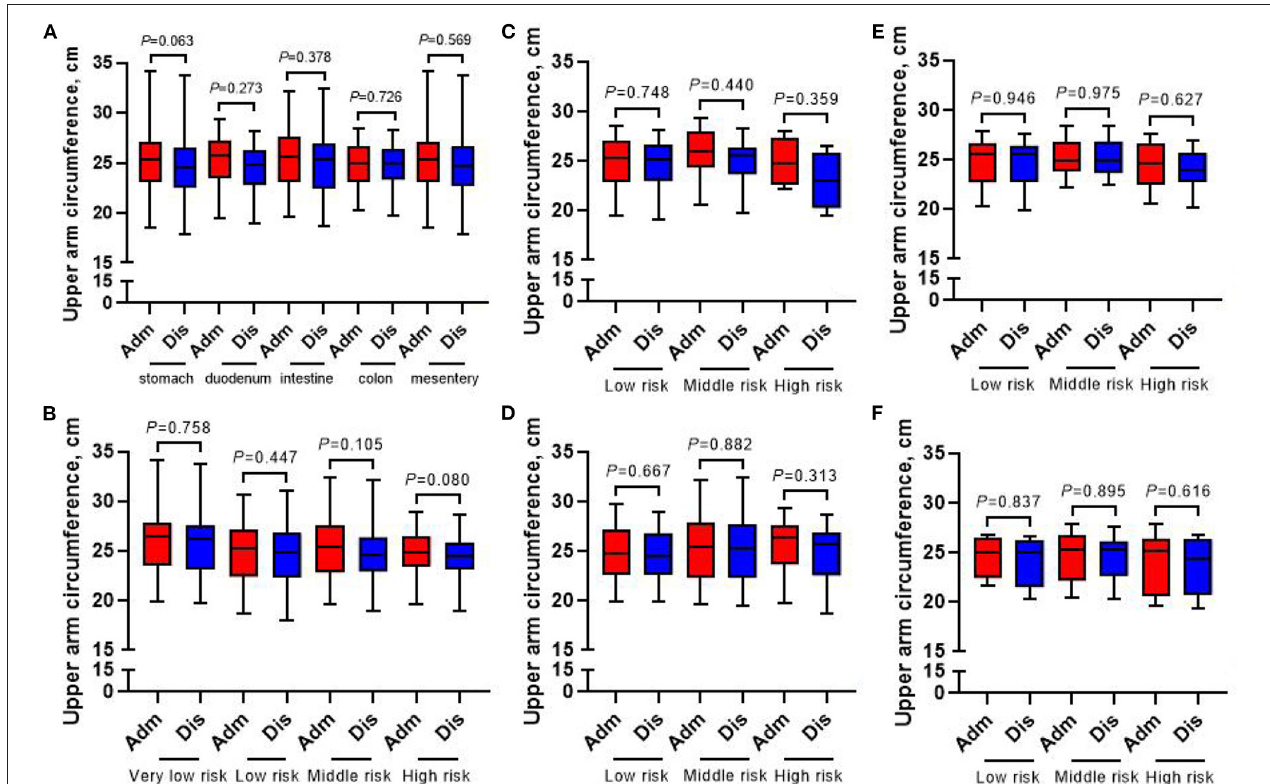
FIGURE 5 | Changes of upper arm circumference in 413 GIST patients at admission and discharge. (A) Total; (B) stomach; (C) duodenum; (D) intestine; (E) colorectal; (F) mesentery.